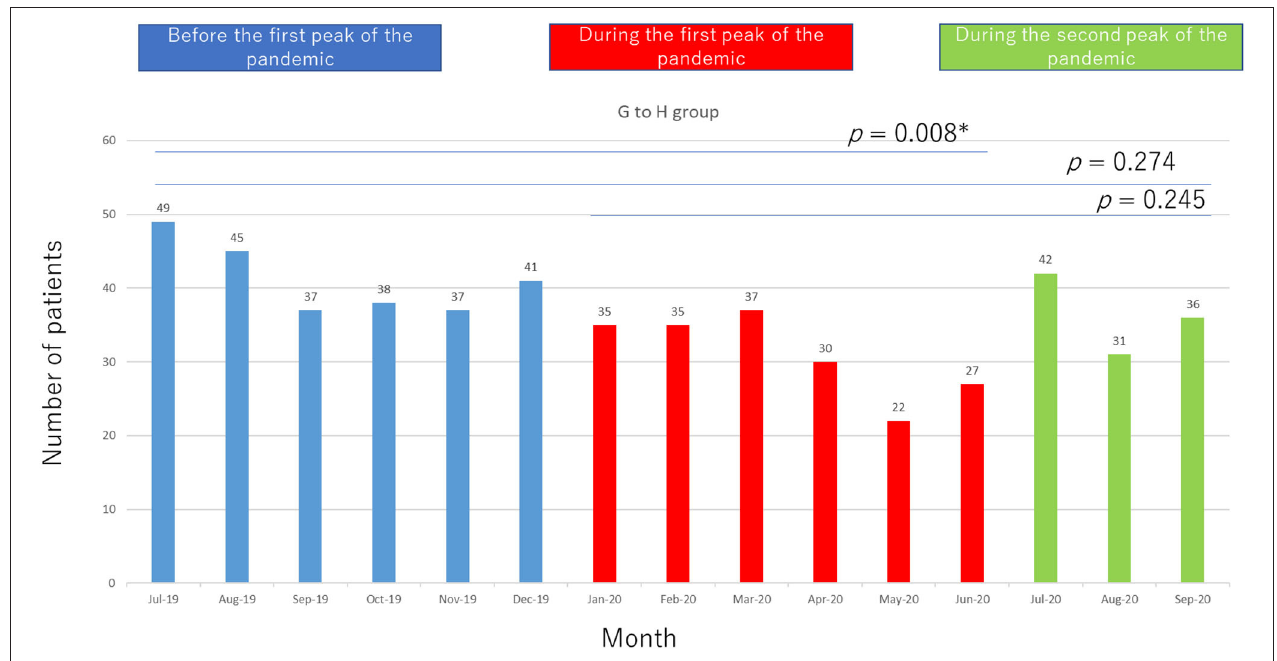
FIGURE 1 | Patient flow from general physicians to our hospital (GP–H group).